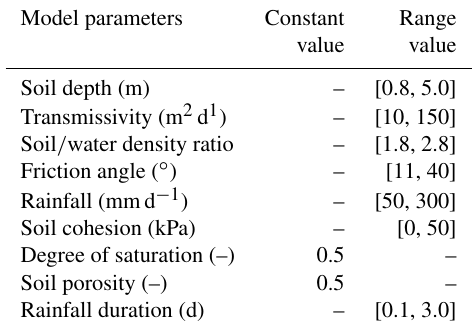
Table 2. Optimized models’ parameter values. Model